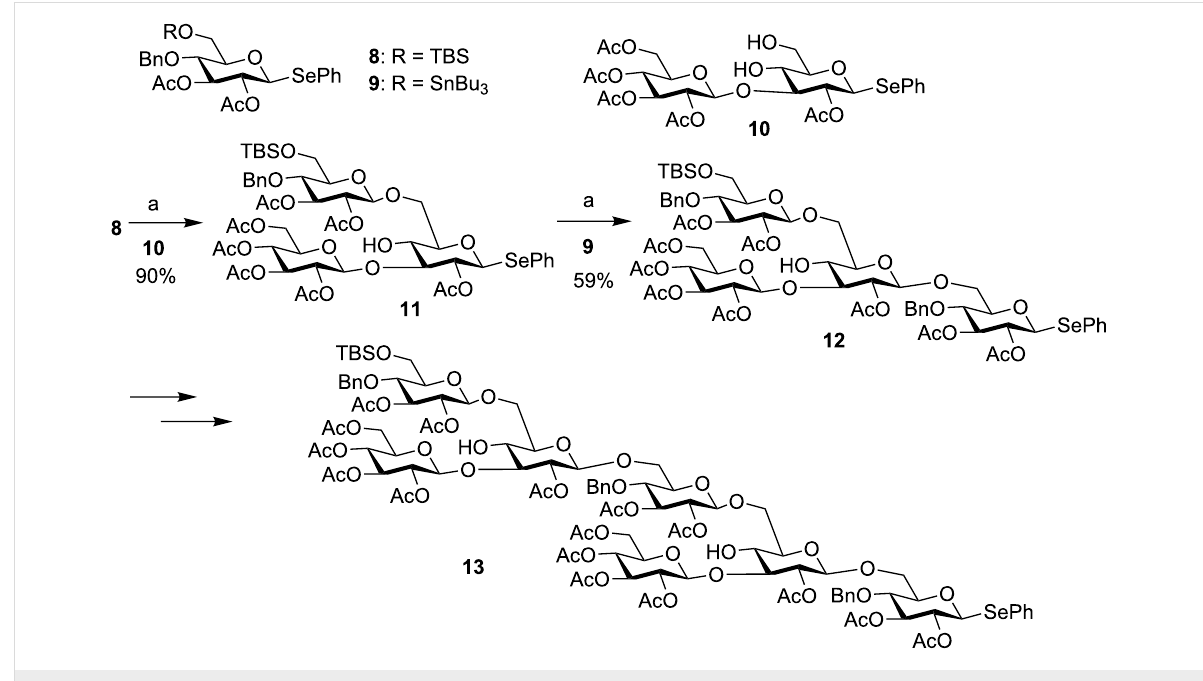
Scheme 4: Glycosyl bromide-mediated selenoglycosyl donor-based iterative glycosylation. Reagents and conditions: (a) Br 2 , (0.5 equiv), 0 °C,